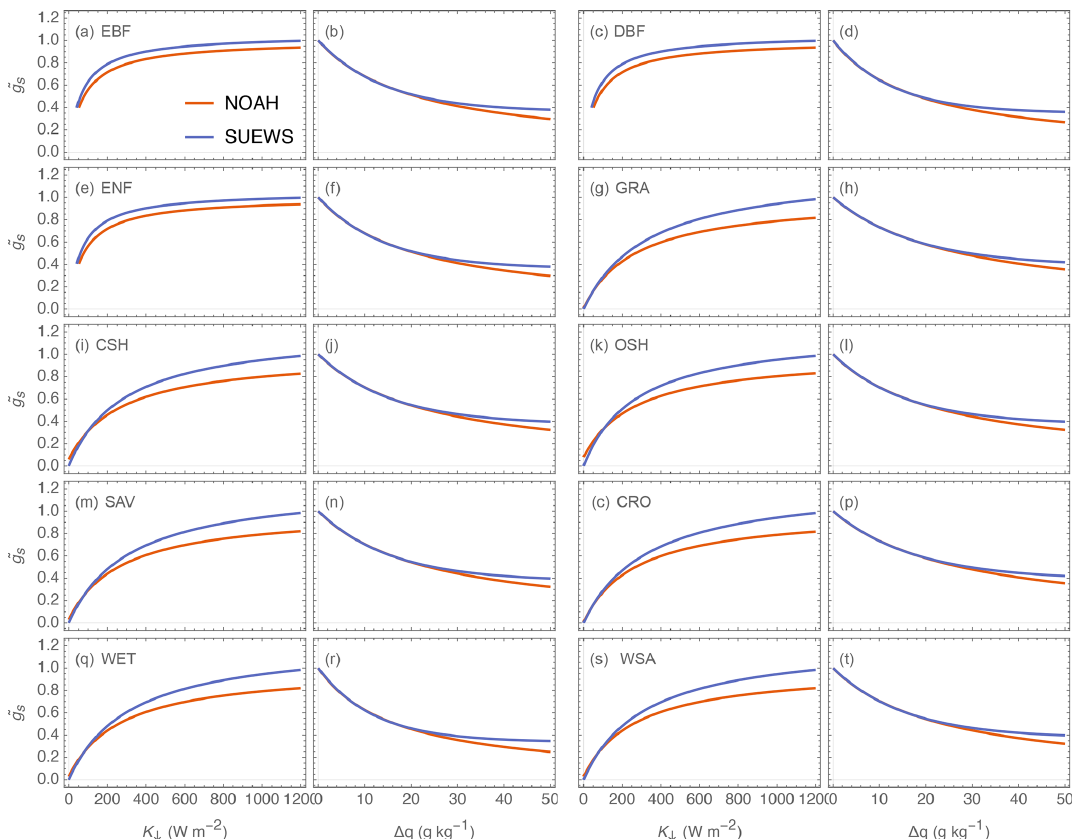
Figure A1. NOAH (red) and SUEWS (blue) surface conductance functions for incoming solar radiation ( K ↓ ) and specific humidity deficit ( (cid:49)q ) for different IGBP